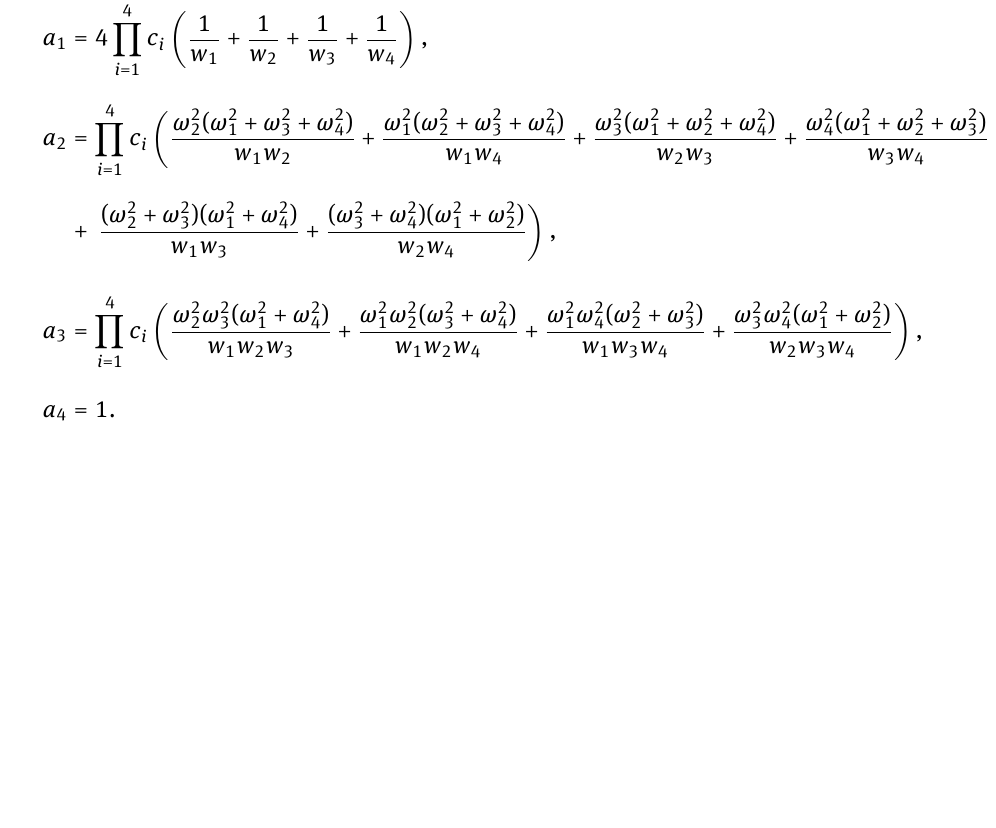
Next,wecomputethecoefficients b and a involvedintheformulaofthegroupinverse.Thecorresponding spanning trees or rooted forests of any order are represented in Figures